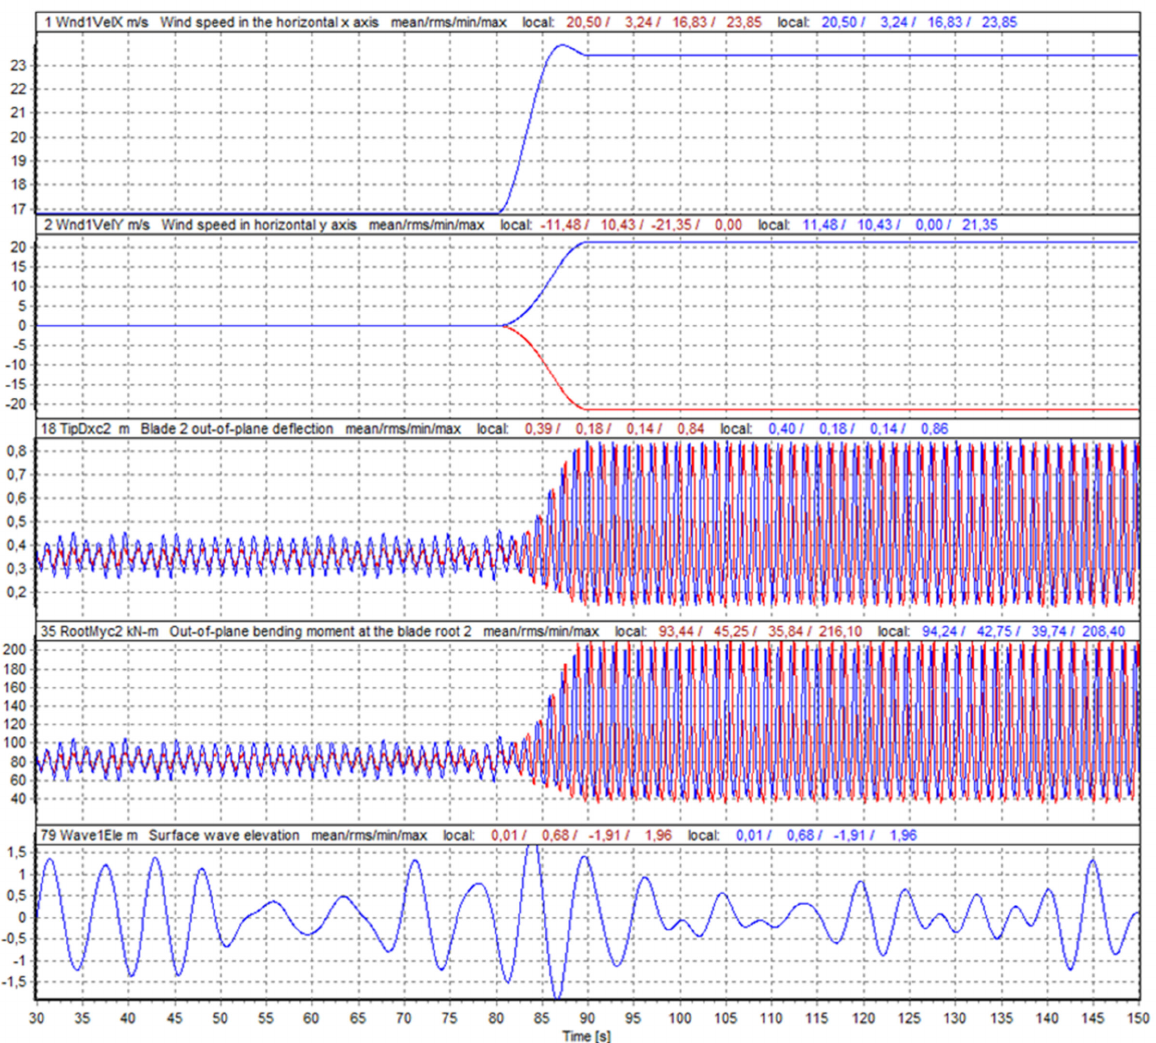
Figure 4. Time histories from DLC 1.4 simulation number 6 (shown in red) and simulation number 431 (shown in blue) for the offshore CART system